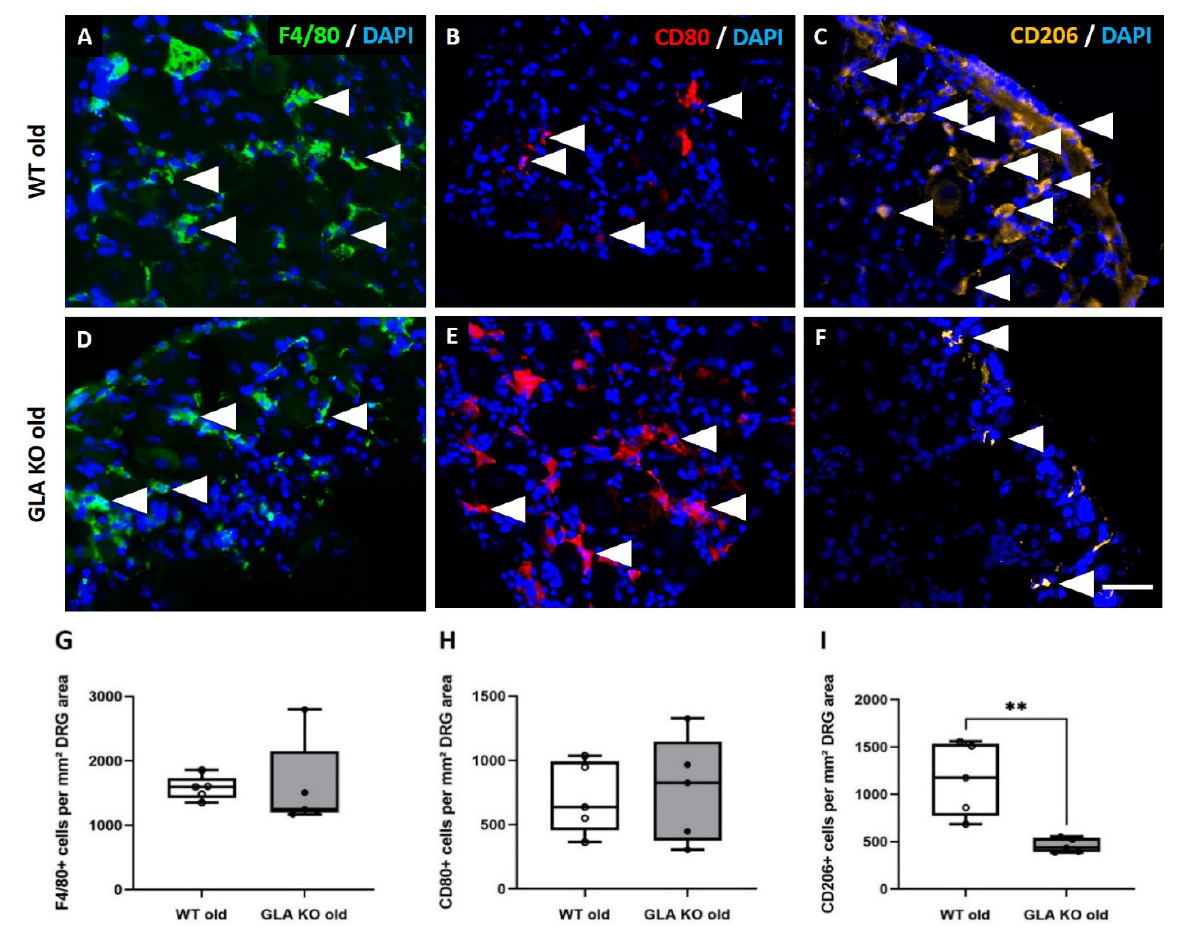
Figure 3. Macrophage subtypes in DRG of old WT and GLA KO mice. ( A – F ) Representative photomicrographs of F4/80 + ( A , D ), CD80 + ( B , E ), and CD206 + ( C , F ) macrophages (arrowheads) in DRG of old WT and old GLA KO mice. ( G ) Quantification of F4/80 + pan-macrophages per mm² DRG area in old WT ( , n = 5) and old GLA KO mice ( , n = 5). ( H ) Quantification of CD80 + M1 macrophages per mm² DRG area in old WT ( , n = 5) and old GLA KO mice ( , n = 5). ( I ) Quantification of CD206 + M2 macrophages per mm² DRG area in old WT ( , n = 5) and old GLA KO mice ( , n = 5). Abbre- viations: CD = Cluster of Differentiation; DAPI = 4 ′ ,6-diamidino-2-phenylindole; DRG = dorsal root